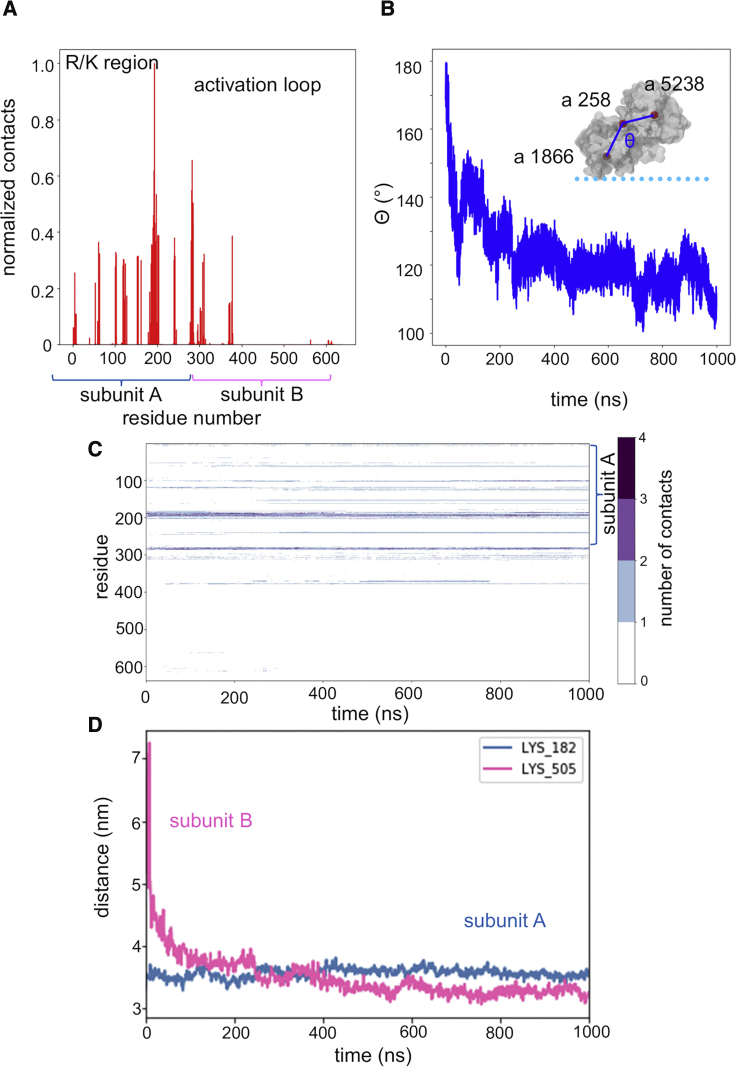
Atomistic Simulations of the PIP5K1A Dimer Bound to the PI4P Containing Membrane(A) Normalized number of contacts between PIP5K1A residues and PI4P molecules in the membrane. The distribution of contacts remains similar. It is notable that, in this replicate, the middle of the activation loop has folded up out of the membrane with the end residues making numerous contacts with PI4P.(B) Angle metric (θ) describing the orientation of the two subunits in the simulated dimer with respect to each other over time. The inset shows a schematic of the definition of θ (defined by atoms 1,866, 358, 5,238 in residues K182, V29, K505). The angle decreases from 180° at the start of simulation (corresponding closely to the crystallographic dimer) to ∼140° where it remains for most of the simulation with transient periods around 110°.(C) Contacts as defined by a 0.35 nm cutoff between the residue COM and the PI4P head group COM show PIPs collecting near the active site (DLKGS, simulation residues 180–184), while PIP contacts with the activation loop (simulation residues 280–300) remain fairly constant. Note that, with the exception of a small number of contacts made with PI4P by the activation loop in subunit B at the start of the simulation, there are no major contacts made by subunit B with PI4P.(D) In contrast to the CG dimer simulation, the dimer was observed to bend at the dimerization interface site to bring the second monomer 4 nm closer to the membrane as shown by subunit B moving from a distance of 7 nm away from the membrane COM to 3 nm in the second half of the simulation. Taken with the angle metric (B), this reveals that the dimer tilts into the membrane bringing subunit B in closer contact with the membrane COM, but this does not result in contacts with PI4P.See Figure S6 and Table 1.